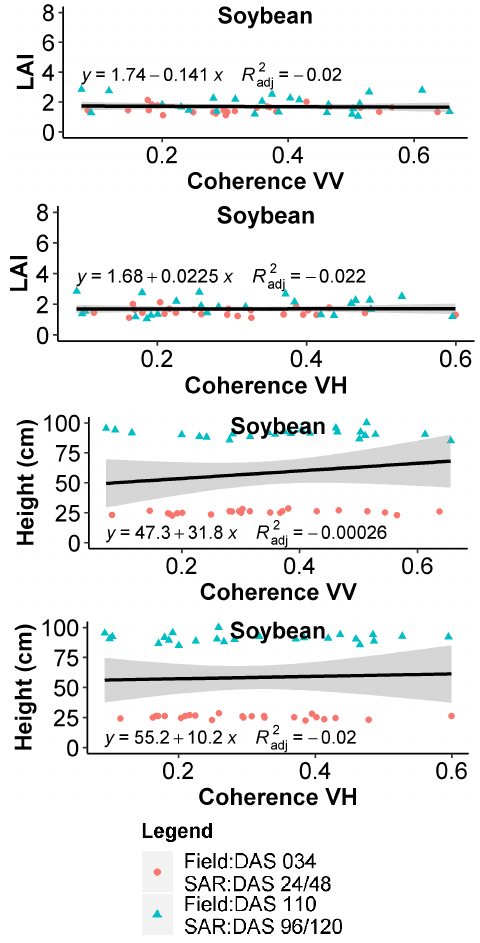
Figure 10. Relationship between biophysical and coherence to soybean